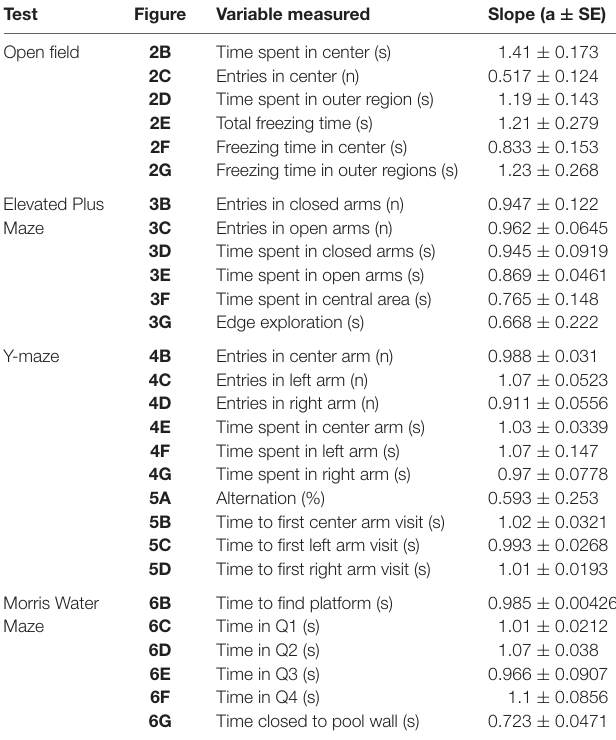
TABLE 2 | Details of the regression slopes. Test